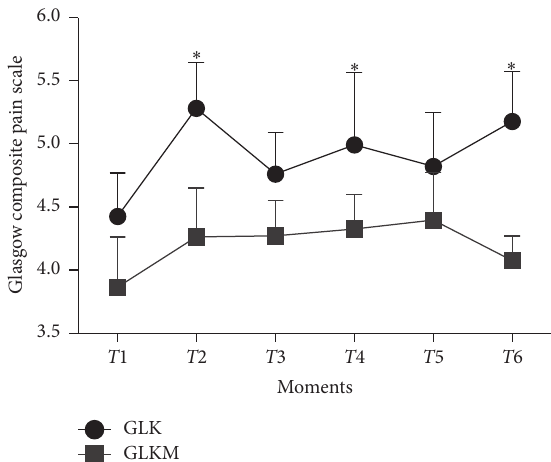
Figure 2: Survival rate in female dogs submitted to unilateral radical mastectomy, continuous infusion of lidocaine and ketamine (GLK), and continuous infusion of lidocaine, ketamine, and maropitant (GLKM) during the six hours of postoperative eval- uation. For the survival test, the first rescue received by each animal was